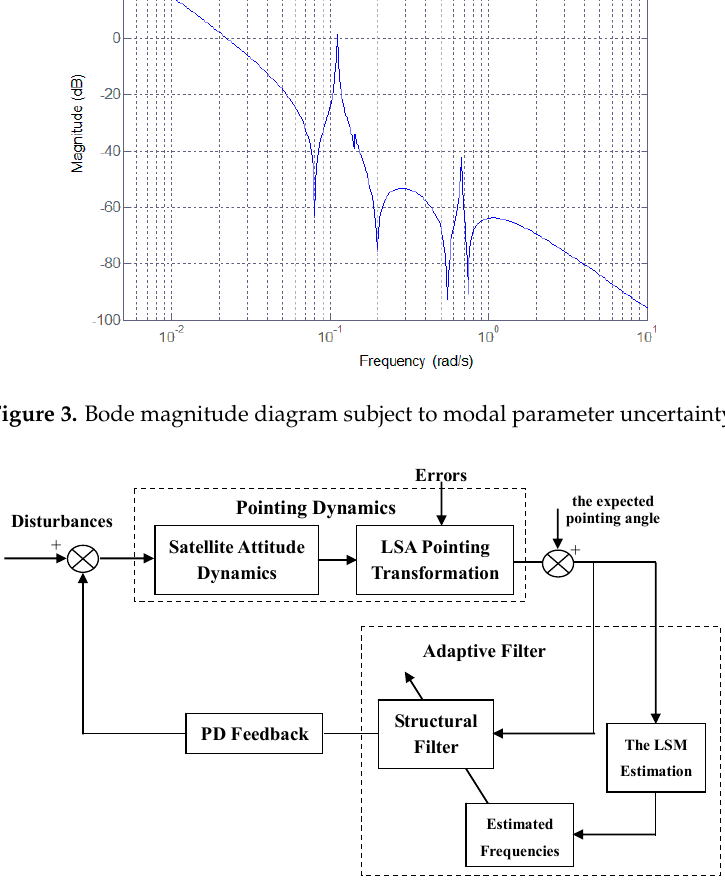
Figure 3. Bode magnitude diagram subject to modal parameter uncertainty.